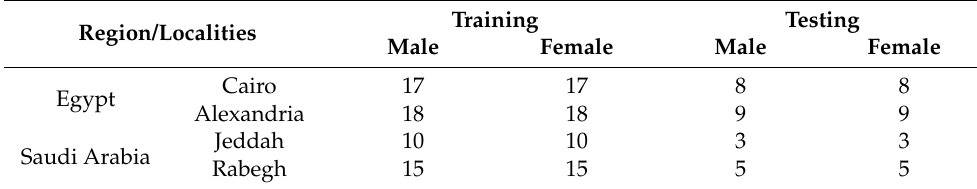
Table 3. Speaking (for training and testing) by regions. Training Testing Region/Localities